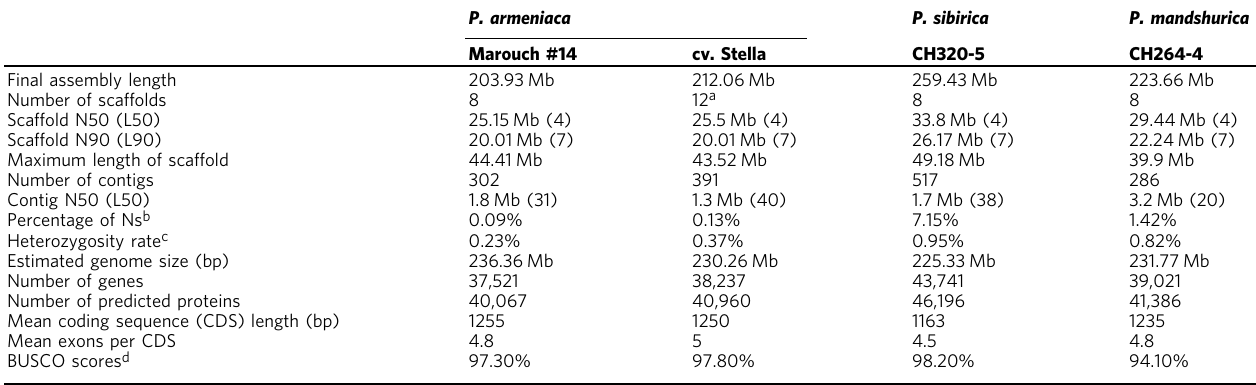
Table 1 Statistics for the genome assemblies of Armeniaca